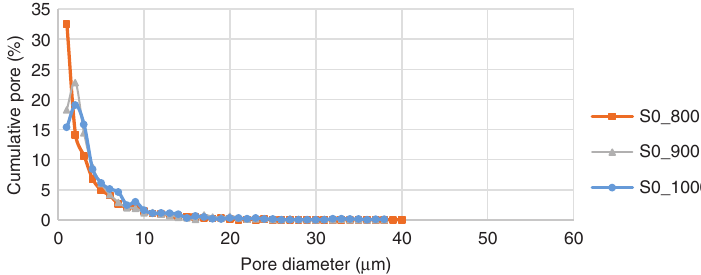
Figure 5: Pore Size Distributions in Raw